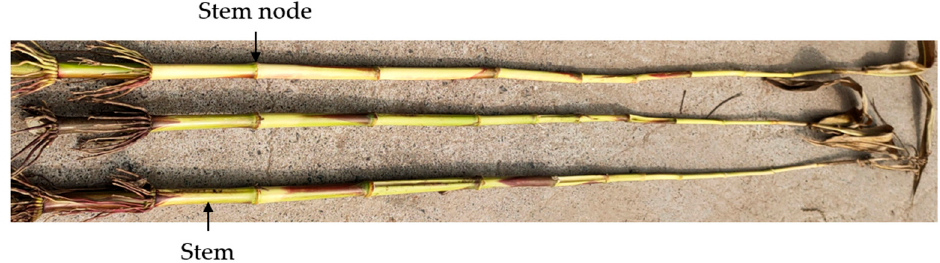
Figure 2. The fi rst stem and stem node of the maize stalk. Figure 2. The first stem and stem node of the maize